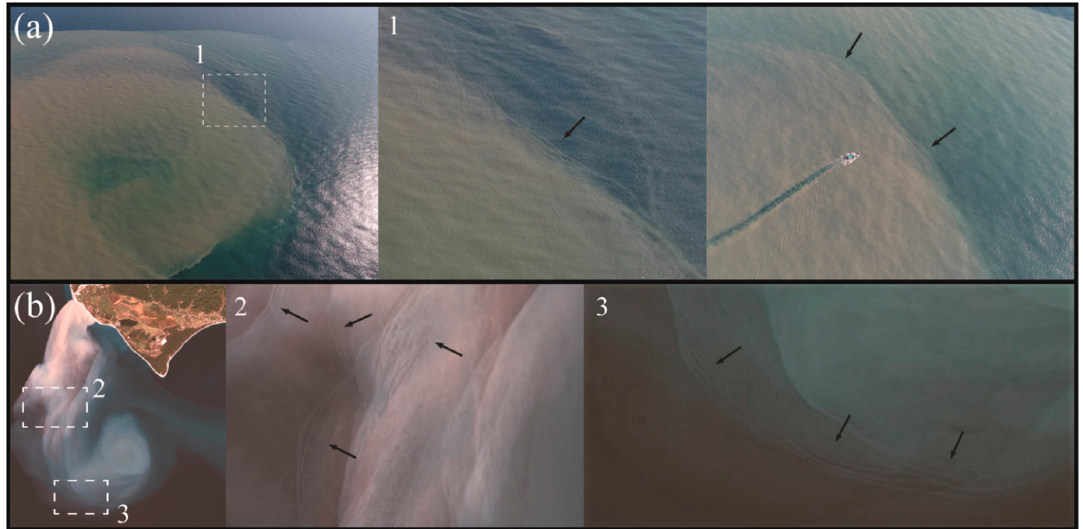
Figure 9. Surface manifestations of high-frequency internal waves generated by the eddies within the ( a ) Kodor and ( b ) Bzyp plumes at ( a ) aerial images acquired on 1 September 2018 and ( b ) satellite images acquired on 10 October, 2019. The central picture at panel ( a ) is the zoomed fragment of the left picture at panel ( a ) indicated by the white dashed rectangle 1. The central and right pictures at panel ( b ) are the zoomed fragments of the left picture at panel ( b ) indicated by white dashed rectangles 2 and 3, respectively. Black arrows indicate surface manifestations of internal waves. Remote Sens. 2020 , 12 , x FOR PEER REVIEW